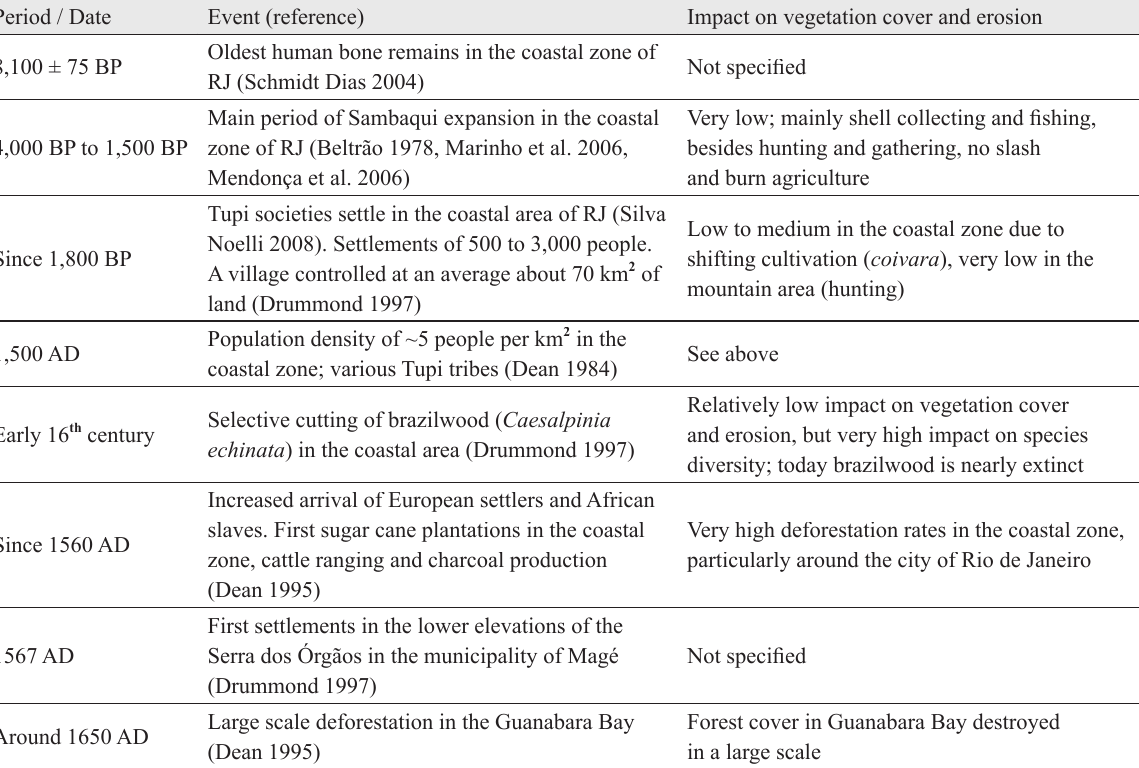
Milestones of historical land use and its impacts on vegetation cover and erosion processes in Rio de Janeiro state